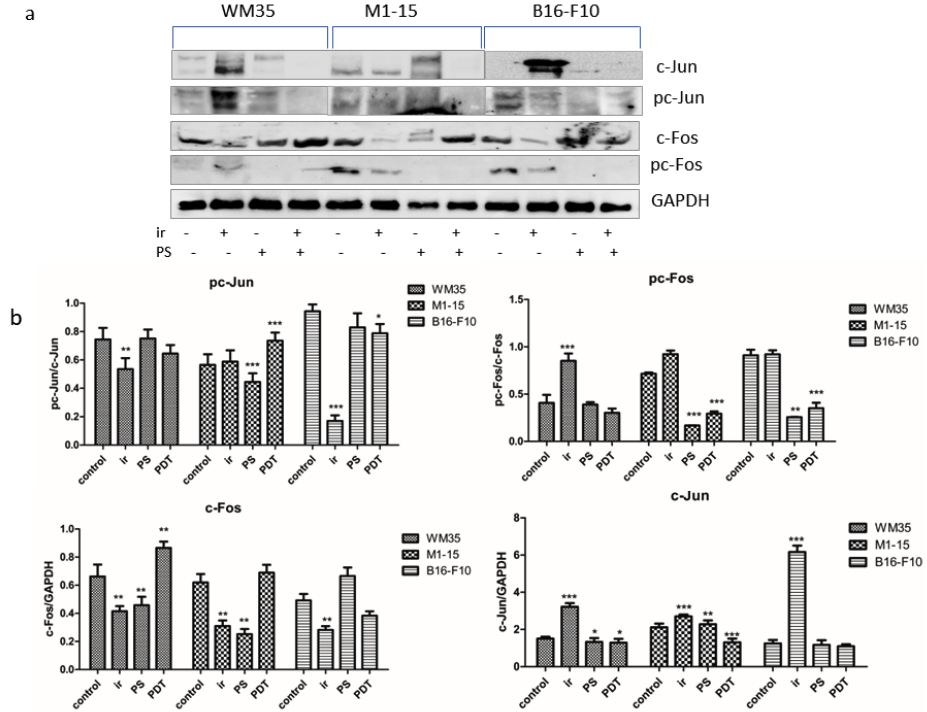
Figure 8. AP1 transcription factors. ( a ) Expression of c-Jun, pc-Jun, c-Fos, and pc-Fos. 1 = control, 2= irradiated control, 3 = THPP, 4 = PDT. ( b ) Graphical representation of quantitative WB results. Each bar represents mean ± SD ( n = 3). * = p < 5.0 × 10 − 2 , ** = p < 1.0 × 10 − 2 , *** = p < 1.0 × 10 − 3 , compared to control. 1 = control, 2 = irradiated (100 mJ/cm 2 ), 3 = THPP (15 µg/mL), 4 = PDT (THPP 15 µg/mL and irradiation 100 mJ/cm 2 ).